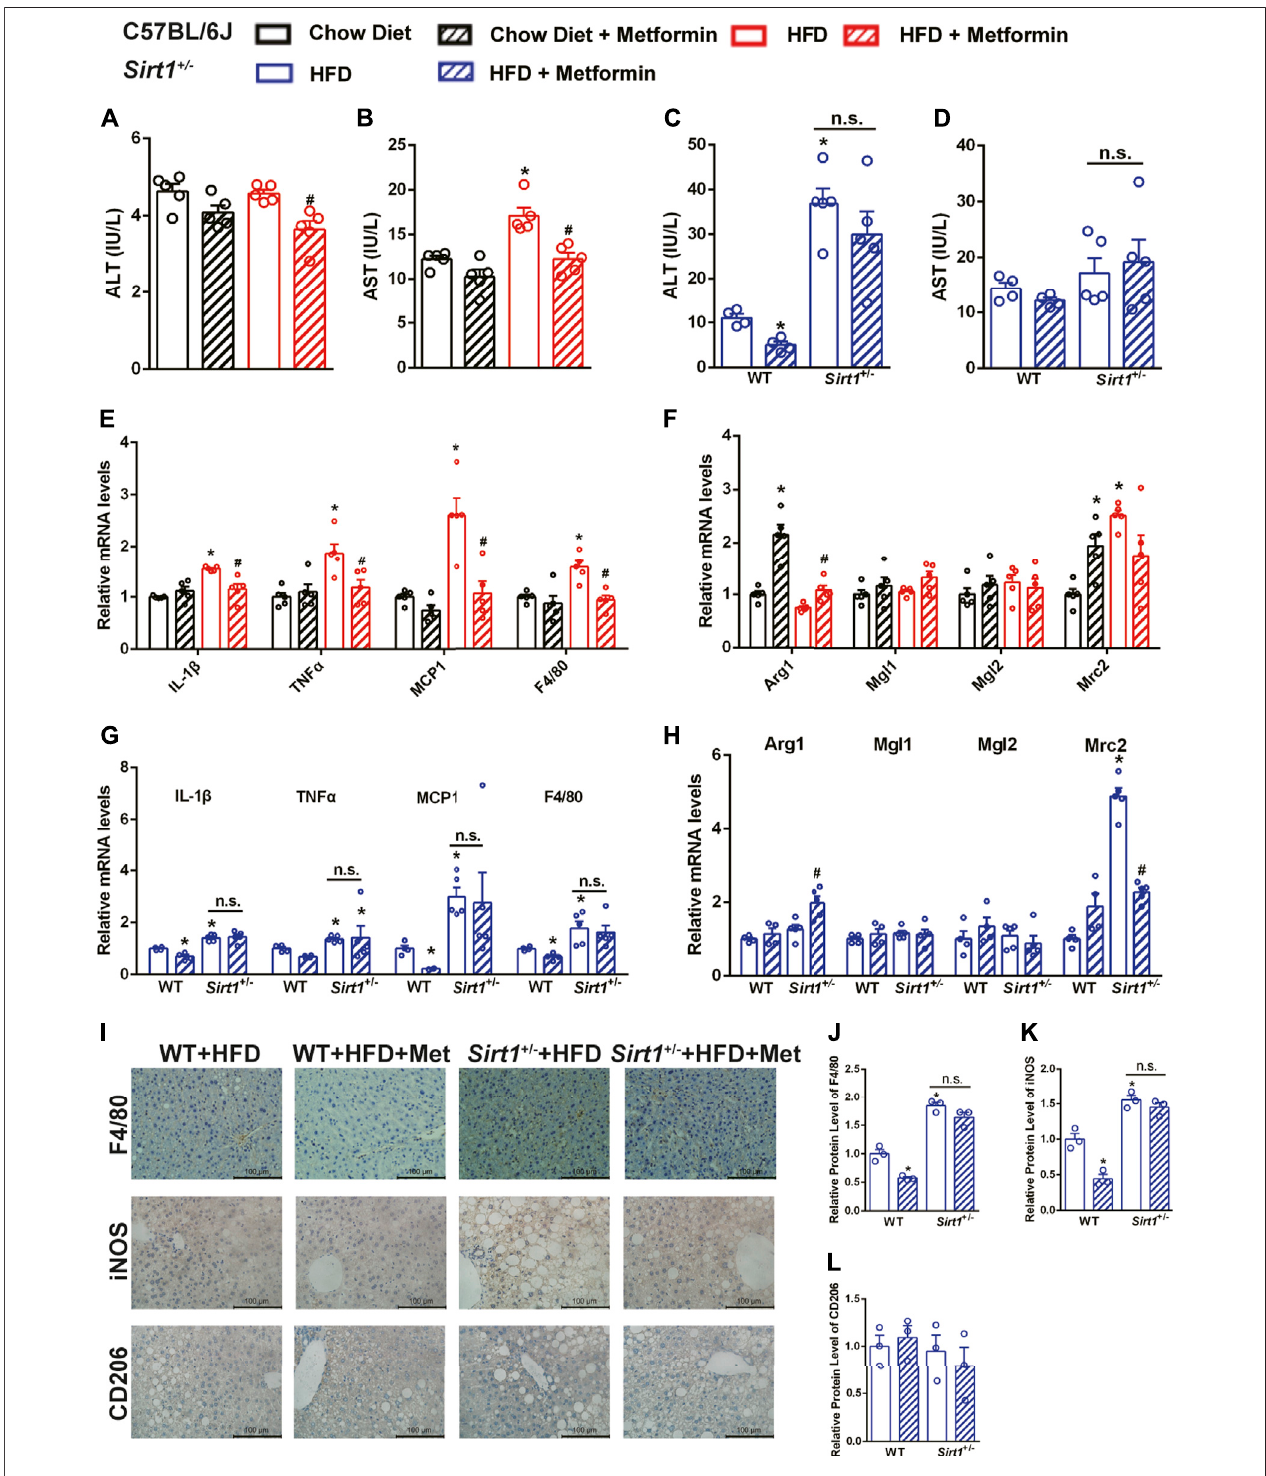
FIGURE 5 | The effect of metformin on ameliorating diet-induced steatohepatitis is diminished in Sirt 1 +/- mice. After metformin treatment, (A) Serum alanine transaminase (ALT), (B) Aspartate transaminase (AST) and (E) the relative mRNA levels of M1 markers were signi fi cantly decreased ( p ＜ 0.05) while (F) the relative mRNA levels of M2 markers were unaffected in DIO mice ( p ＞ 0.05). SIRT1 de fi ciency impaired the effect of metformin on decreasing (C) serum ALT levels and downregulating (G) the relative mRNA expressions of M1 markers ( p ＞ 0.05). (H) The relative mRNA levels of M2 markers were also unaffected by metformin in Sirt1 1 +/ − mice ( p ＞ 0.05). (I – L) The F4/80,M1 markersiNOS, M2 markers CD206immunohistochemical staining,and the quanti fi cation ofthose protein expressions of